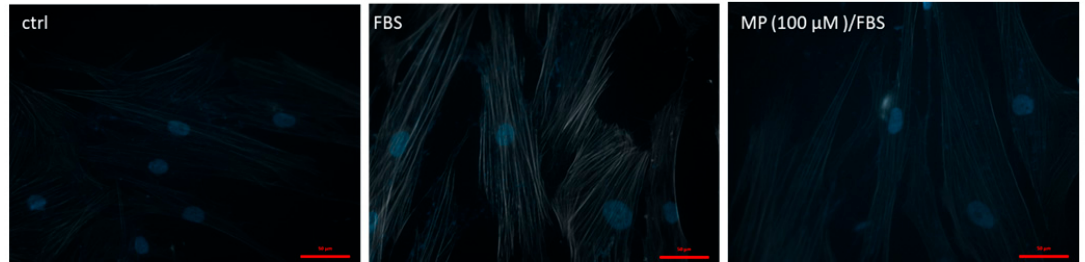
Figure 9. MP attenuates FBS-induced actin polymerization. Cells were treated with FBS for 24 h in the presence or absence of MP (100 µM). Cells were then stained with phalloidin and actin polymerization was assessed. Representative micrographs showing the effect of MP on FBS-induced actin-polymerization. Scale bar, 50 µm.